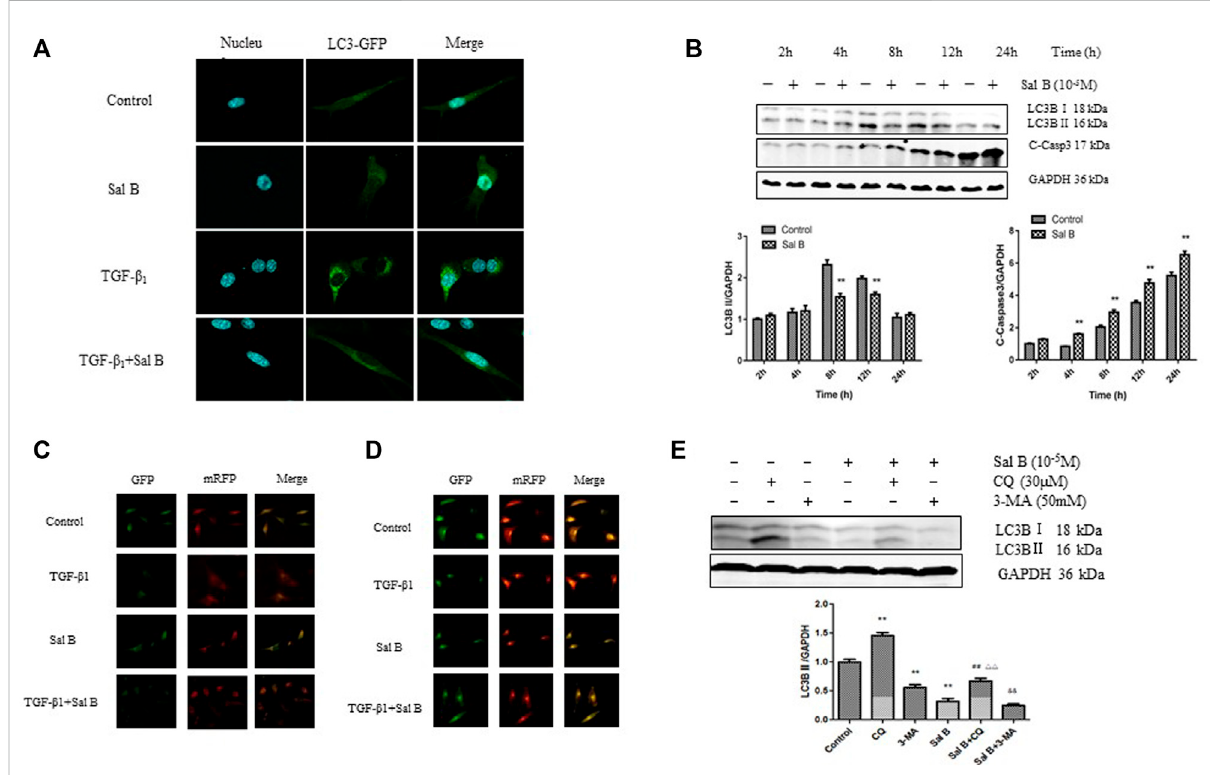
FIGURE 1 Sal B inhibits the formation of autophagosomes and autophagic fl ux induced by TGF- β 1 in JS1 and LX2 (A) LC3-GFP plot of JS1 in different groups . (B) Expressions of LC3B and cleaved-Caspase 3 in JS1 were detected by WB. (C,D) Representative fl uorescence inversion microscope images showing GFP (green) and RFP (red) in JS1 (C) and LX2 (D) . (E) Expression of LC3B in JS1 was detected by WB ( n = 3 vs . control: p p < 0.05, pp p < 0.01;vs . SalB, ## : p < 0.01;vs . CQ, △△ : p < 0.01;vs . 3-MA, && : p < 0.01)SalB:salvianolicacidB;C-Casp3:cleaved-caspase3;TGF- β 1:transforming growth factor- β 1; CQ:chloroquine; 3-MA: 3-